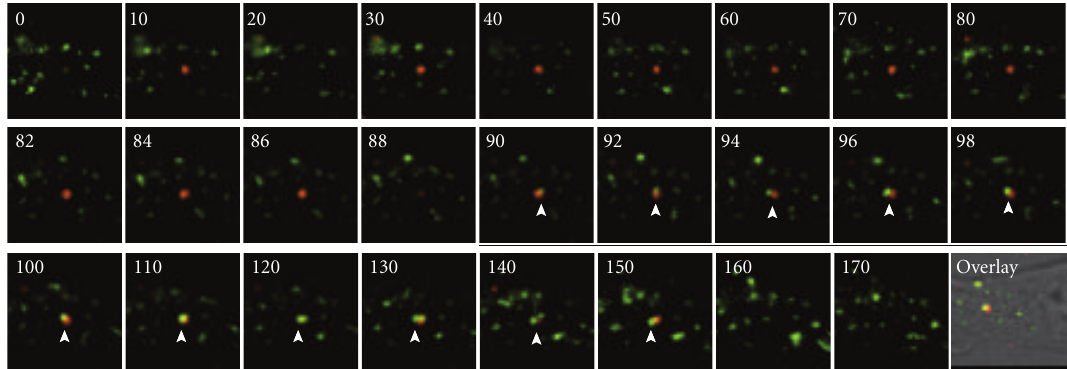
Figure 3: Dual color TIRFM of SINV and Rab-5 after endocytosis. A SINV virus after entering the cell was tracked (red). After approximately 90 seconds, it was associated with GFP-Rab5 (green). The association lasted ∼ 60 second before the GFP-Rab5 dissociated and the SINV moved deeper into the cell. Time in seconds is labeled. Arrowheads indicate the association of Rab5. The last image shows an overlay composite picture of the